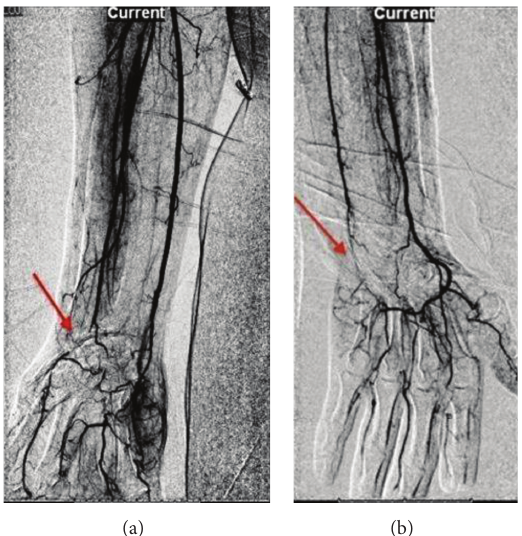
Figure 2: (a) Arrow showing total occlusion of the right radial and ulnar arteries at the wrist level. Filling of the radial artery seen after a short segment. (b) Arrow showing occlusion of the left ulnar artery at the wrist level with an open radial